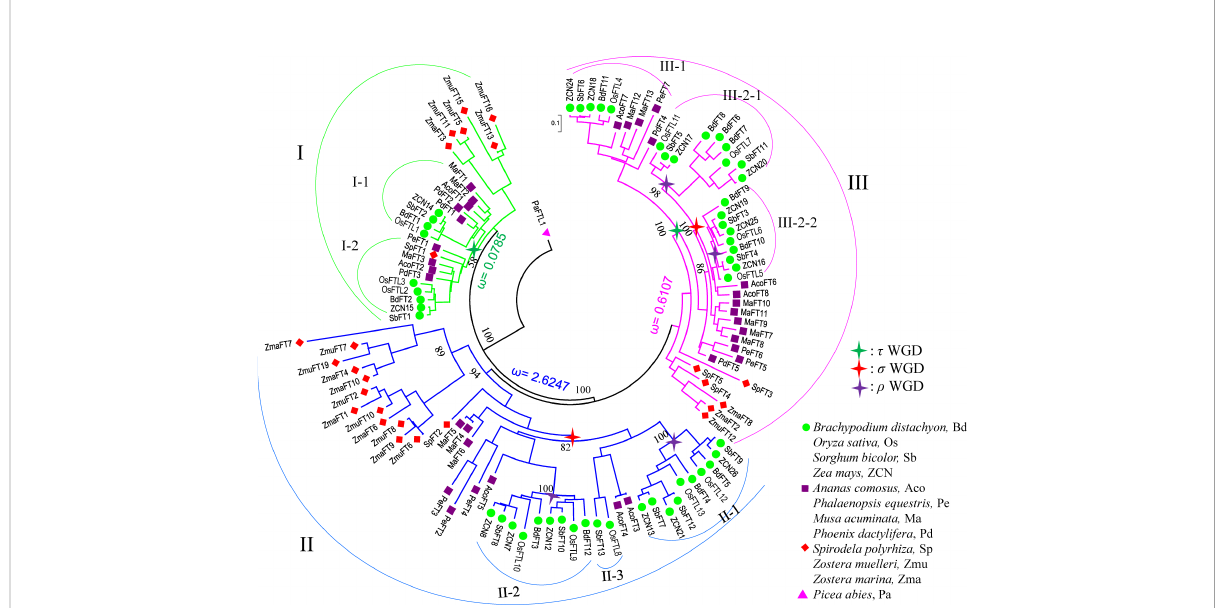
FIGURE 2 The phylogenetic relationship of the FT genes in monocots. The phylogenetic tree was constructed using the Bayes methods. The P. abies FT - like gene (JN039333) was set as the outgroup. The FT members from monocots are classi fi ed into three clades based on the tree; clade I is marked in green, II in blue, and III in pink. The stars mark the WGD event that occurred in monocots: green star, t WGD; red star, r WGD; and purple star, s WGD. Pa, P. abies; Zma, Zostera marina ; Zmu, Zostera muelleri ; Sp, Spirodela polyrhiza ; Pd, Phoenix dactylifera ; Ma, Musa acuminata ; Pe, Phalaenopsis equestris ; Aco, Ananas comosus; Bd, Brachypodium distachyon ; Sb, Sorghum bicolor ; Os, Oryza sativa ; ZCN, Zea mays.